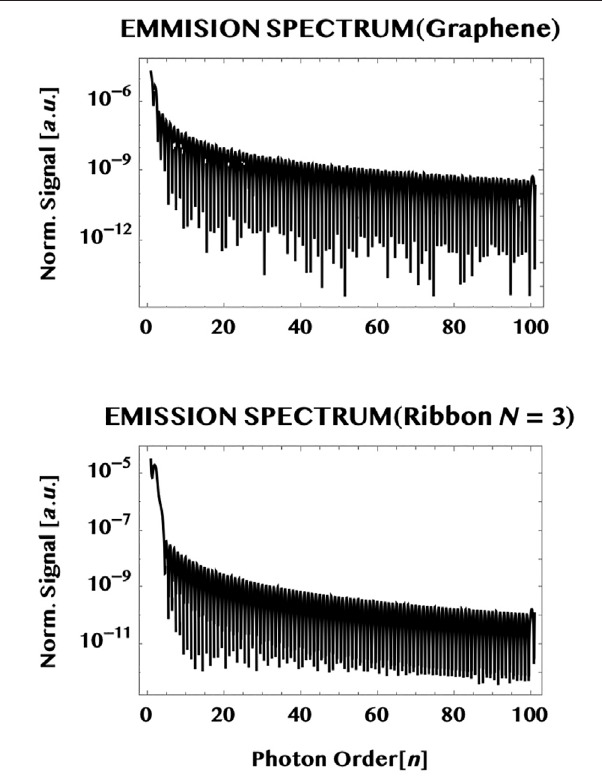
FIGURE 11 | Emission spectra radiated by the ultrashort charge- currents generated in the monolayer graphene (upper plot) and in a graphene ribbon (width, N = 3) (lower plot) by a 1.5 cycles, 800 nm, one TW/cm 2 laser pulse polarised linearly parallel to the armchair edge ( y -axis). Notice that both the spectra exhibit similar characteristics i.e. a rapid fall in intensity within a few photon orders followed by a low but broad plateau that extends over many orders (over one